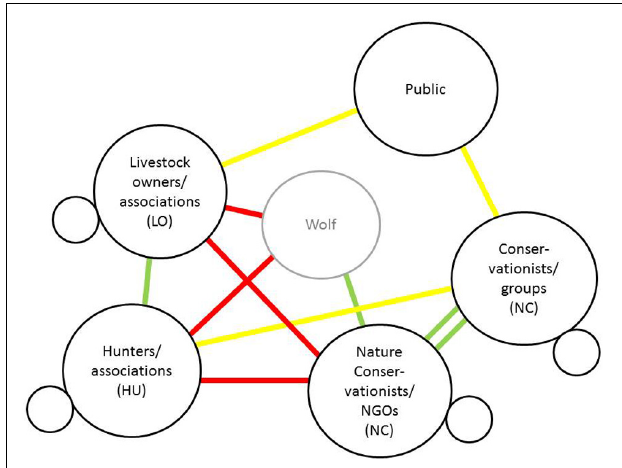
FIGURE 2 | Model stakeholder map (green=positive, red=negative, yellow=neutral relationship; no line=no relationship; based on Lüchtrath, 2017).